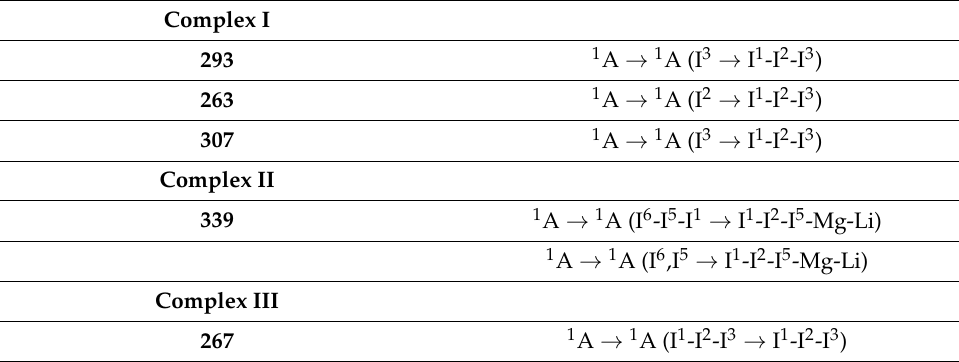
Table 3. The wavelengths of electronic transitions (nm) in Complexes I–III.